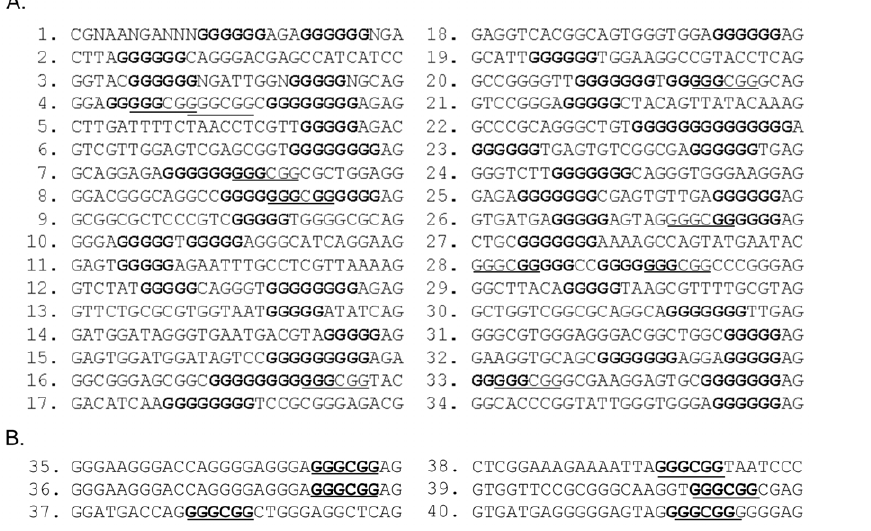
Figure 4. Nucleotide sequence of DNA fragments selected by the CASTing method. dsDNA (CASTrandom oligonucleotide, Table S3, after synthesis of the complementary strand using PCR-specific primers CAST-F and CAST-R) was incubated with Zbed4 to form protein-DNA complexes that were immunoprecipitated using Zbed4 antibody and protein A-Sepharose beads. Bound DNA was extracted, PCR-amplified and used for the next round of CASTing. Three rounds of CASTing were performed. The amplified DNA fragments that interacted with Zbed4 were cloned and sequenced. A . Clones carrying poly-G tracts (bolded) and GC-box core sequences (underlined). B . Clones only carrying GC-box core sequences.